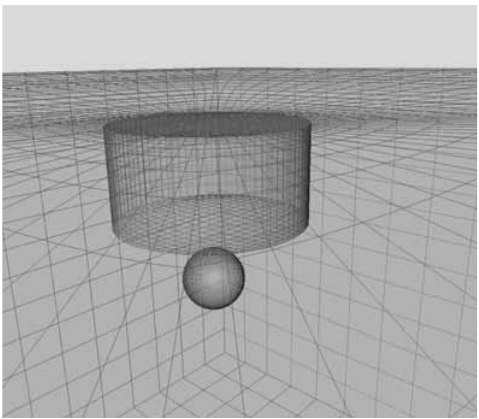
Fig. 5. Perspective view of the FE model. The caldera is a cylinder of radius 3 km and height 3 km, surrounded by a layer of similar thickness on top of the halfspace. The Mogi source is shown at a depth of 5 km, with a radius of 1